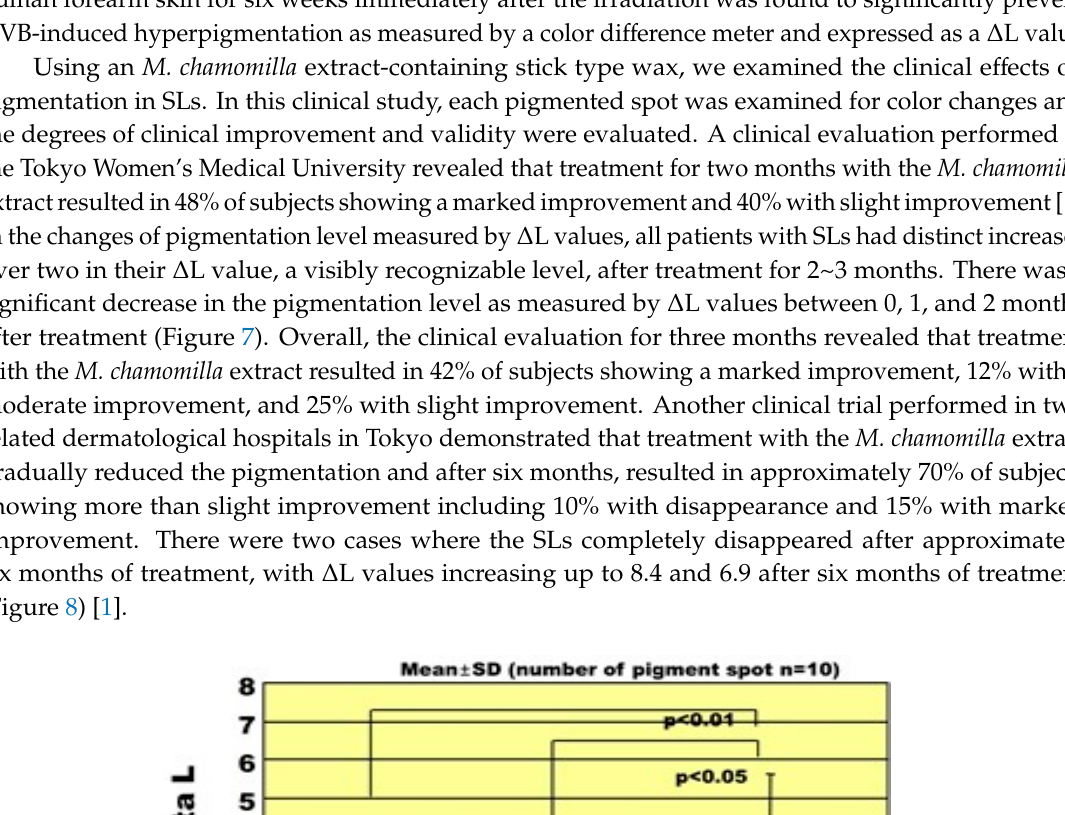
Figure 8. Two clinical cases where the SLs completely disappeared [1]. In conclusion, regarding therapeutic approaches for SLs by blocking essential melanogenic intracellular signaling, the above clinical studies suggest that blocking EDN1/EDNBR-associated signaling is an effective therapeutic treatment for SLs without any hypopigmenting effects. 5.2. Inhibiting Tyrosinase Activity Inhibiting tyrosinase activity is another approach for ameliorating the hyperpigmentation in SLs that has possible drawbacks of hypopigmentation, but the potential benefit of also being effective in non-lesional skin. As whitening agents are generally designed to treat UVB-melanosis, there has not been a clinical double-blinded study for the potential anti-pigmenting effects of whitening agents on SLs. We conducted a double-blinded half face study on 27 Japanese female volunteers with SLs. In that clinical study, lotions with or without 6% L-ascorbate-2-phosphate 3 Na (APS) (test lotion/placebo lotion, respectively) were topically applied twice daily on the face for 24 weeks [45]. Representative photographs of the faces of subjects No. 012 and No. 016 before and after treatment demonstrated that the pigmentation level of the test lotion-treated SLs appeared to slightly decrease in concert with a slight decrease in the test lotion-treated non-lesional skin [45]. In contrast, the pigmentation level of the placebo lotion-treated SLs and the non-lesional skin appeared to remain unchanged. Whereas L values in the test lotion-treated SLs significantly increased after 24 weeks of treatment, L values in the placebo lotion-treated SLs remained unchanged (Figure 9) [45].